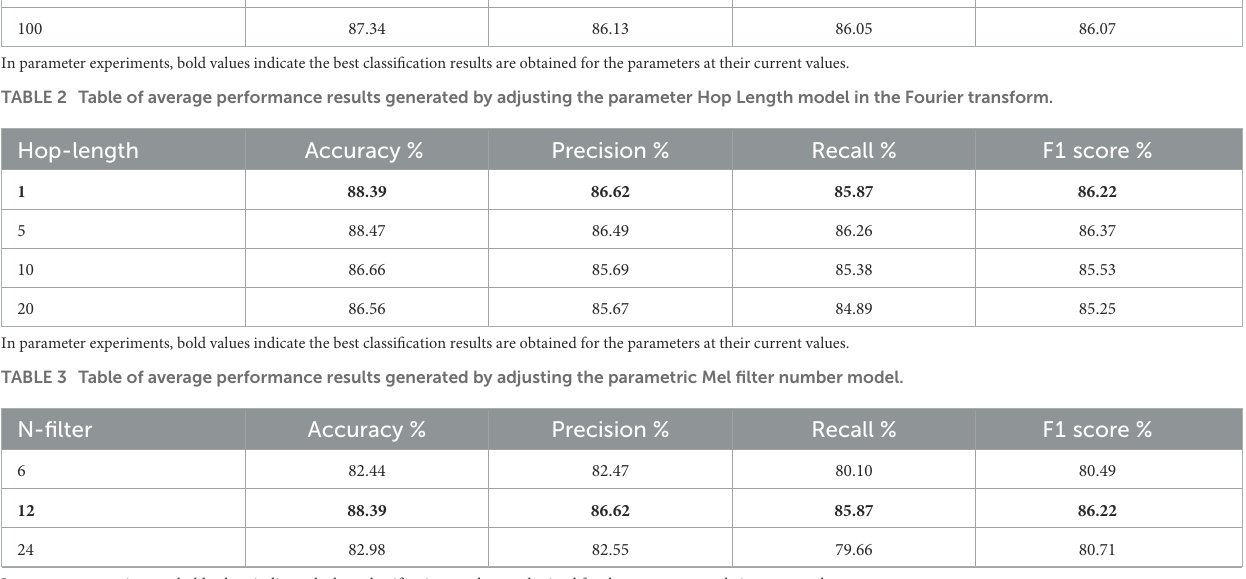
TABLE 4 Table of average performance results generated by the sample rate model for adjusting the parametric Mel filter. Sampling rate